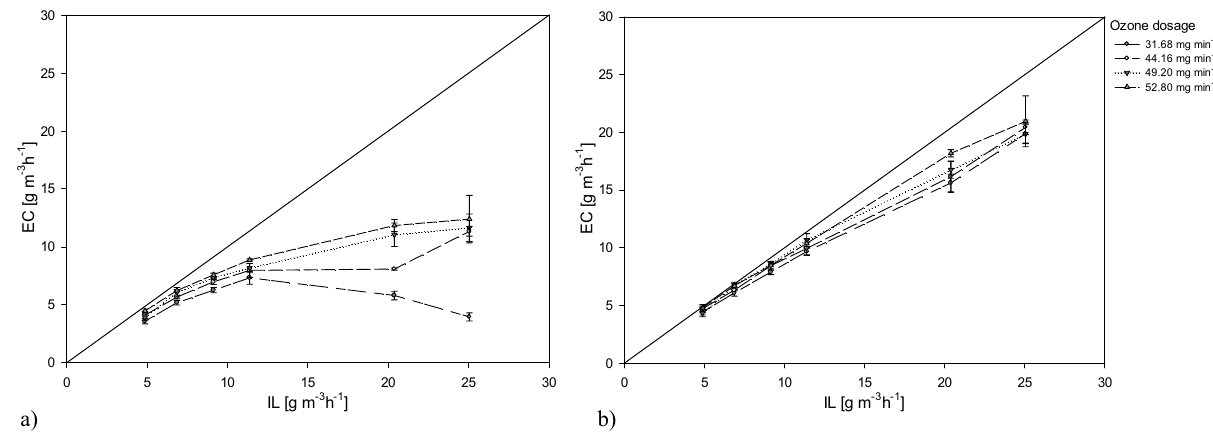
Figure 4. Inlet Load (IL) compared to Elimination Capacity (EC) applying the UV/O3 system ( a ) and the UV/ O3 + S system ( b